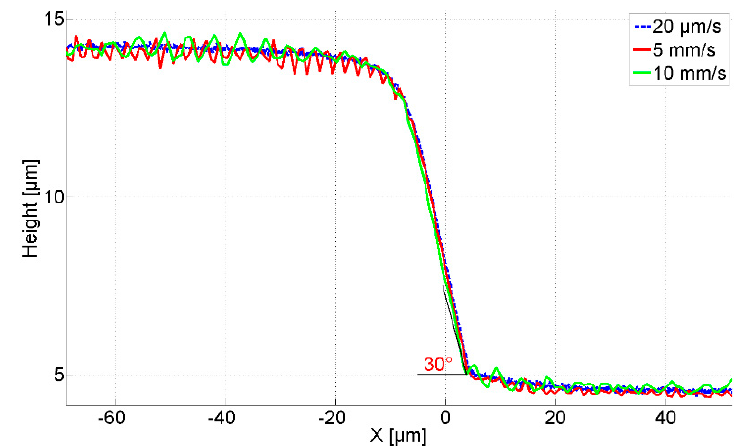
Figure 9. Measured profiles on artifact A using the microprobe with diamond tip with an initial static probing force of 96 µN, at different traverse speeds.